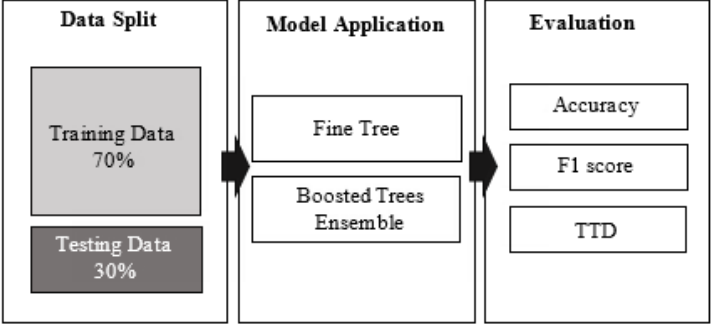
Figure 4. Modelling approach for training and evaluating ML models.